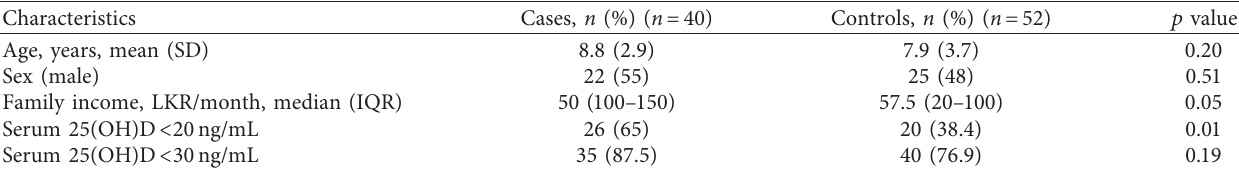
Table 1: Characteristics of the study